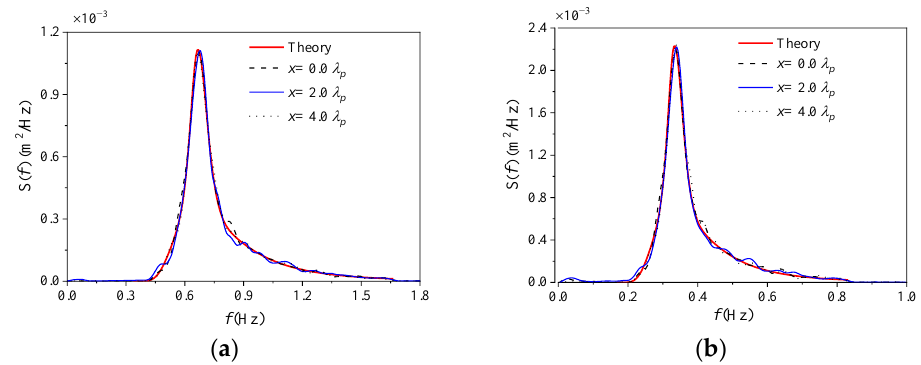
Figure 2. Comparison between input spectrum and incident wave elevation spectrum at different position in the NWT for two peak wave periods. ( a ) T p = 1.5 s, ( b ) T p = 3.0 s.